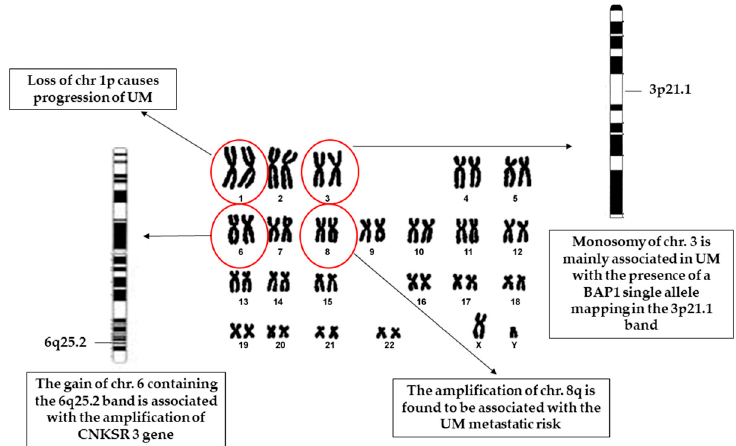
Figure 1. Schematic representation of the human karyotype showing the main chromosome aberrations / mutations, within red circles, detected in uveal melanoma (UM) cases. Karyograms of chromosomes 3 and 6 are represented with specific bands, 3p21.1 and 6q25.2, which contain BAP1 ( BRCA1 -associated protein 1), and CNKSR 3 (member 3 of CNKSR : Connector enhancer of kinase suppressor of RAS), genes, respectively.